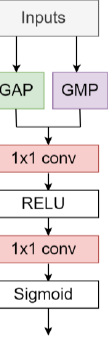
Figure 2. The framework of the GAMP block.